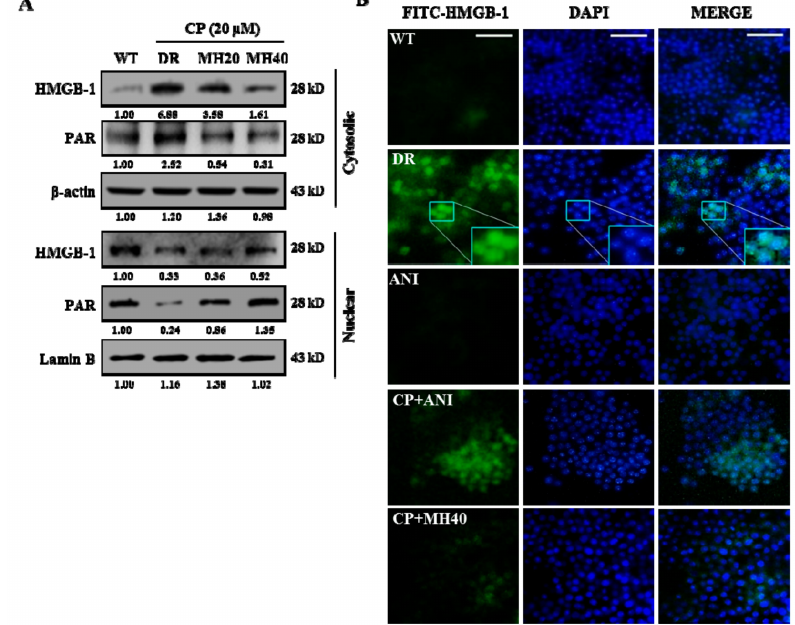
Figure 2. MH suppresses CP-induced cytoplasmic translocation of high-mobility group box 1 (HMGB1). ( A ) Expression levels of HMGB1 and PAR in cytosolic and nuclear fractions of HepG2 DR cells were measured by Western blotting after CP-MH treatments; results were normalized relative to β -actin and lamin B, respectively. Relative intensities were measured by ImageJ software. At least two independent experiments were performed. ( B ) Immunocytofluorescence of HepG2 WT and HepG2 DR cells for cytosolic HMGB1 translocation after ANI, CP-ANI, and CP-MH treatments, performed using a fluorescein isothiocyanate (FITC)-labeled anti-HMGB1 antibody (magnification: 400 × ; scale bar: 0.1 mm); DAPI (blue) was used as a nuclear